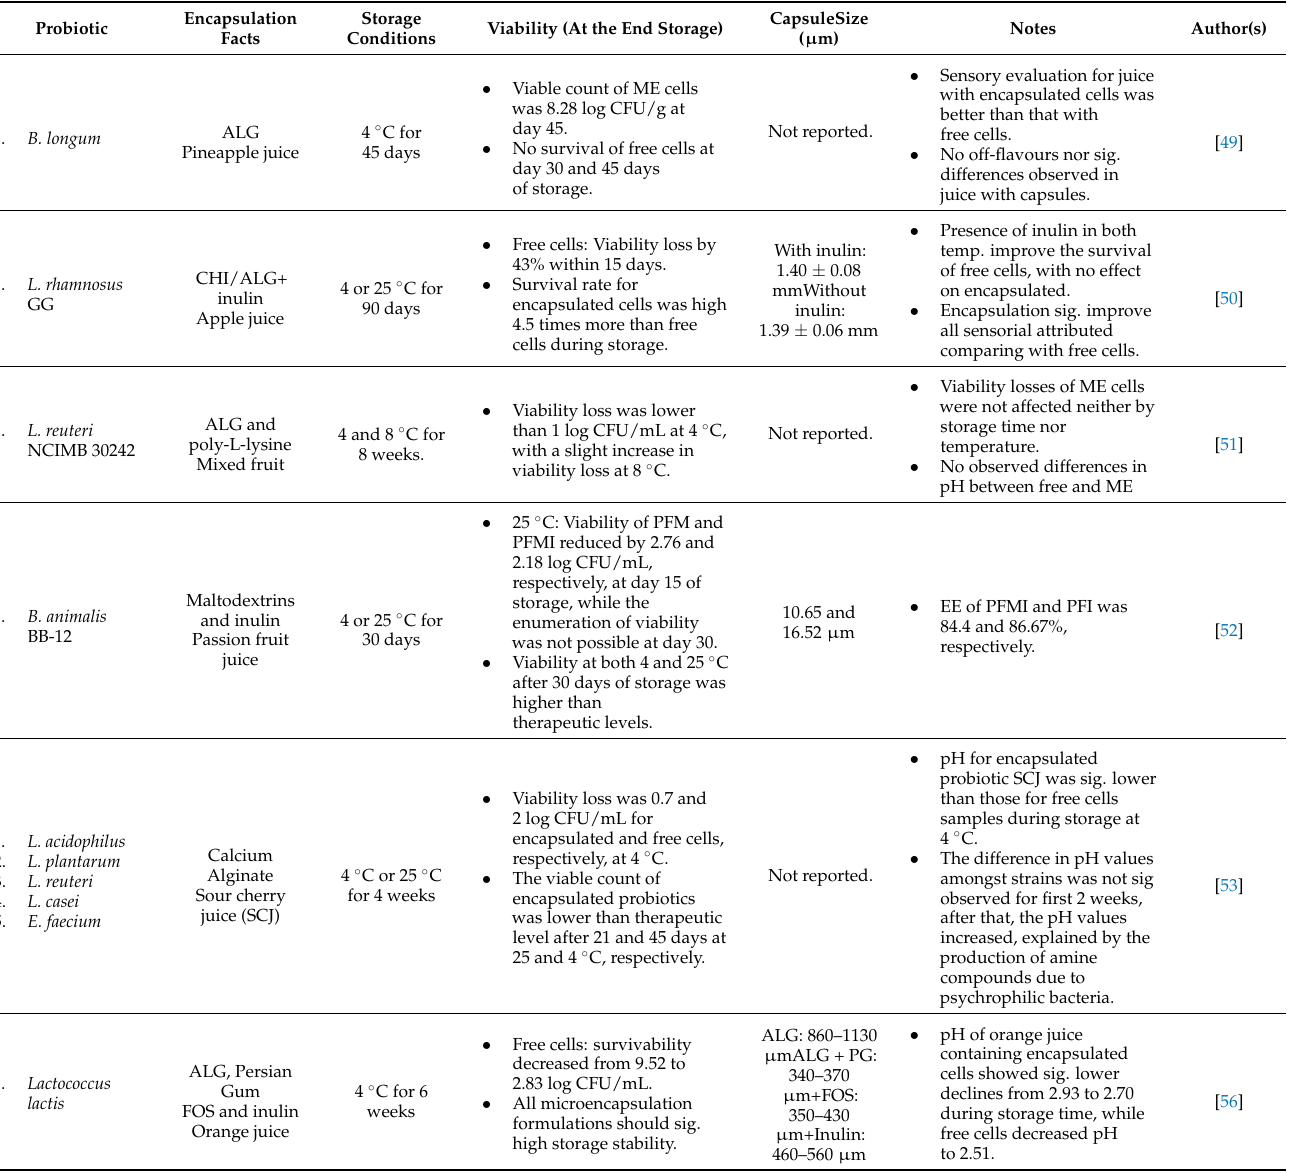
Table 2. Incorporation of microencapsulated probiotics into different types of juices and its effect on viability during